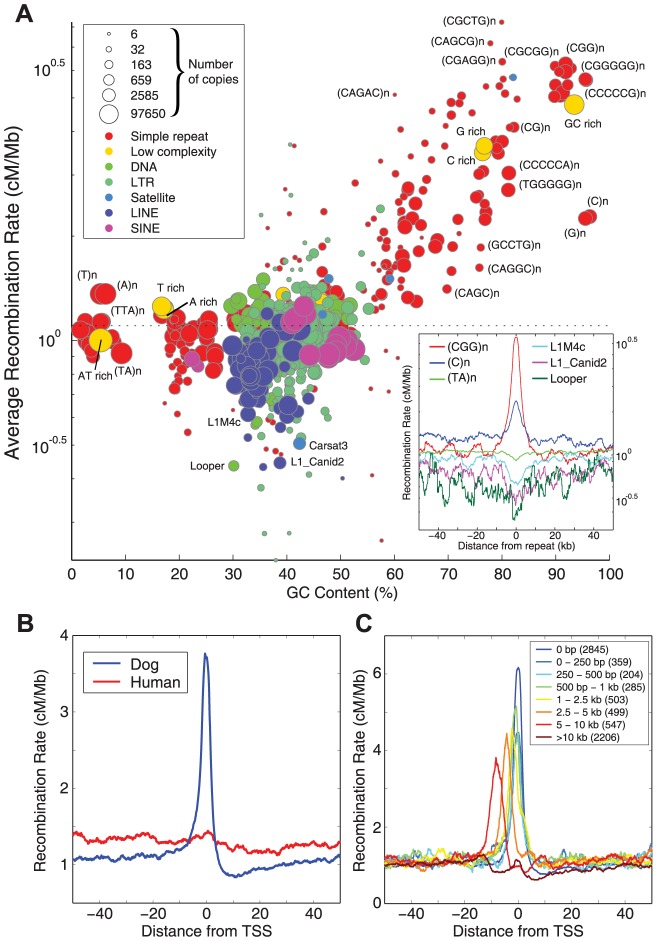
Recombination around genome features.A) Average recombination rates (on a logarithmic scale) for DNA repeats as a function of average GC content. Bubble size gives an indication of the number of repeats in a given family, with colors indicating higher-level repeat classes. Recombination rates for each repeat were estimated in a 5 kb window centered on the repeat, thinned so that no two repeats were within 10 kb. The insert shows (log scale) recombination rates around a selection of repeats. B) Recombination rates around TSS in dog (blue) shows an elevation that dwarfs the small elevation seen in human (red). C) Recombination rates around TSS partitioned on the basis of distance to the nearest CpG island (as defined by the UCSC genome browser), ranging from genes with a CpG island overlapping the TSS (dark blue) to genes with no CpG island within 10 kb (dark red).